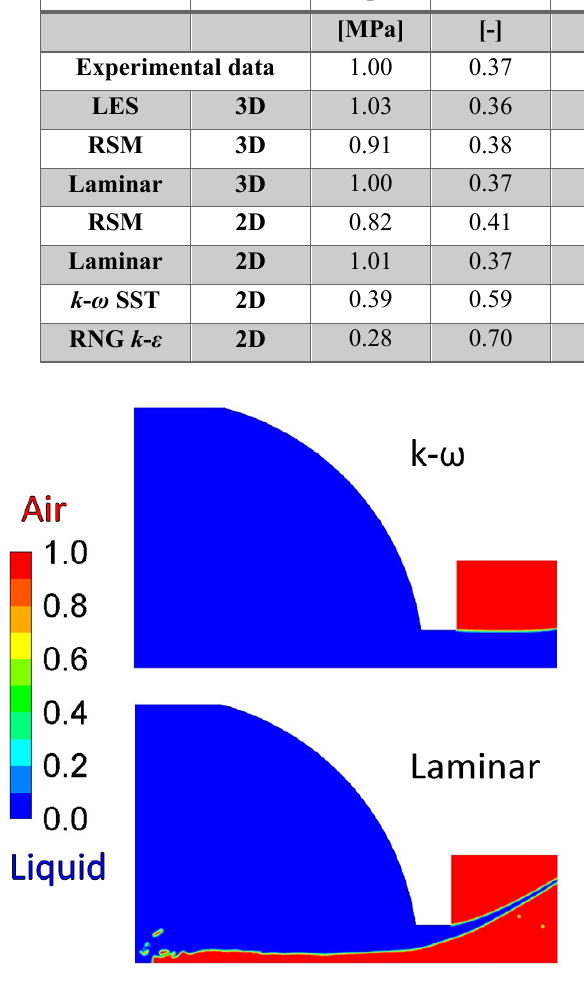
Fig. 7. Phases, red = air, blue = liquid. Top: 2D k - ω model, bottom: 2D laminar